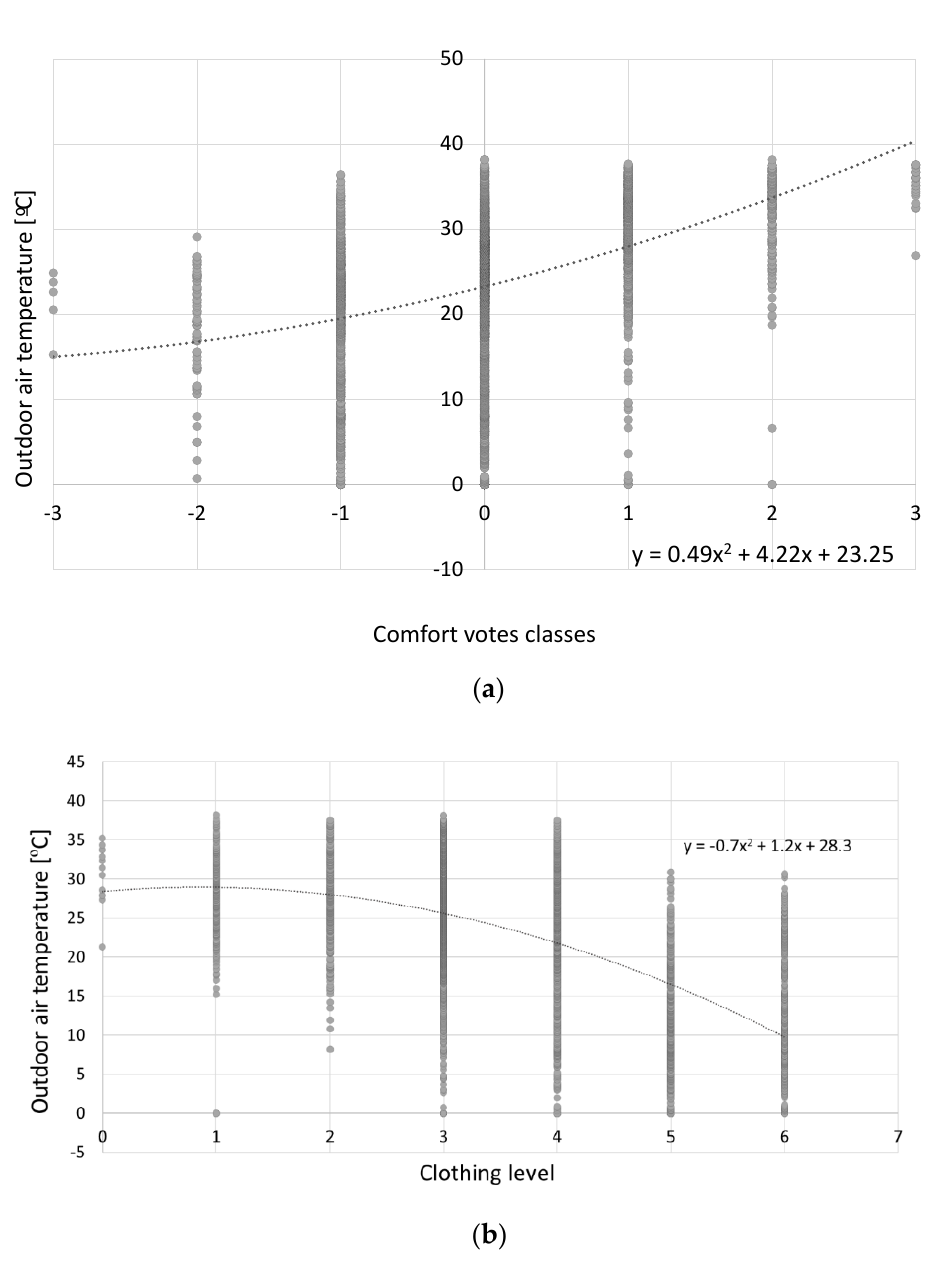
Figure 6. Indoor air temperature and thermal comfort votes scatter plot.